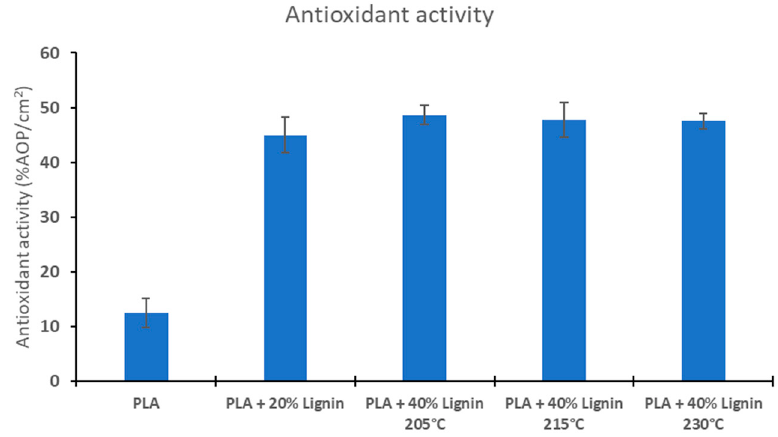
Figure 8. Antioxidant activity of PLA and biocomposites.